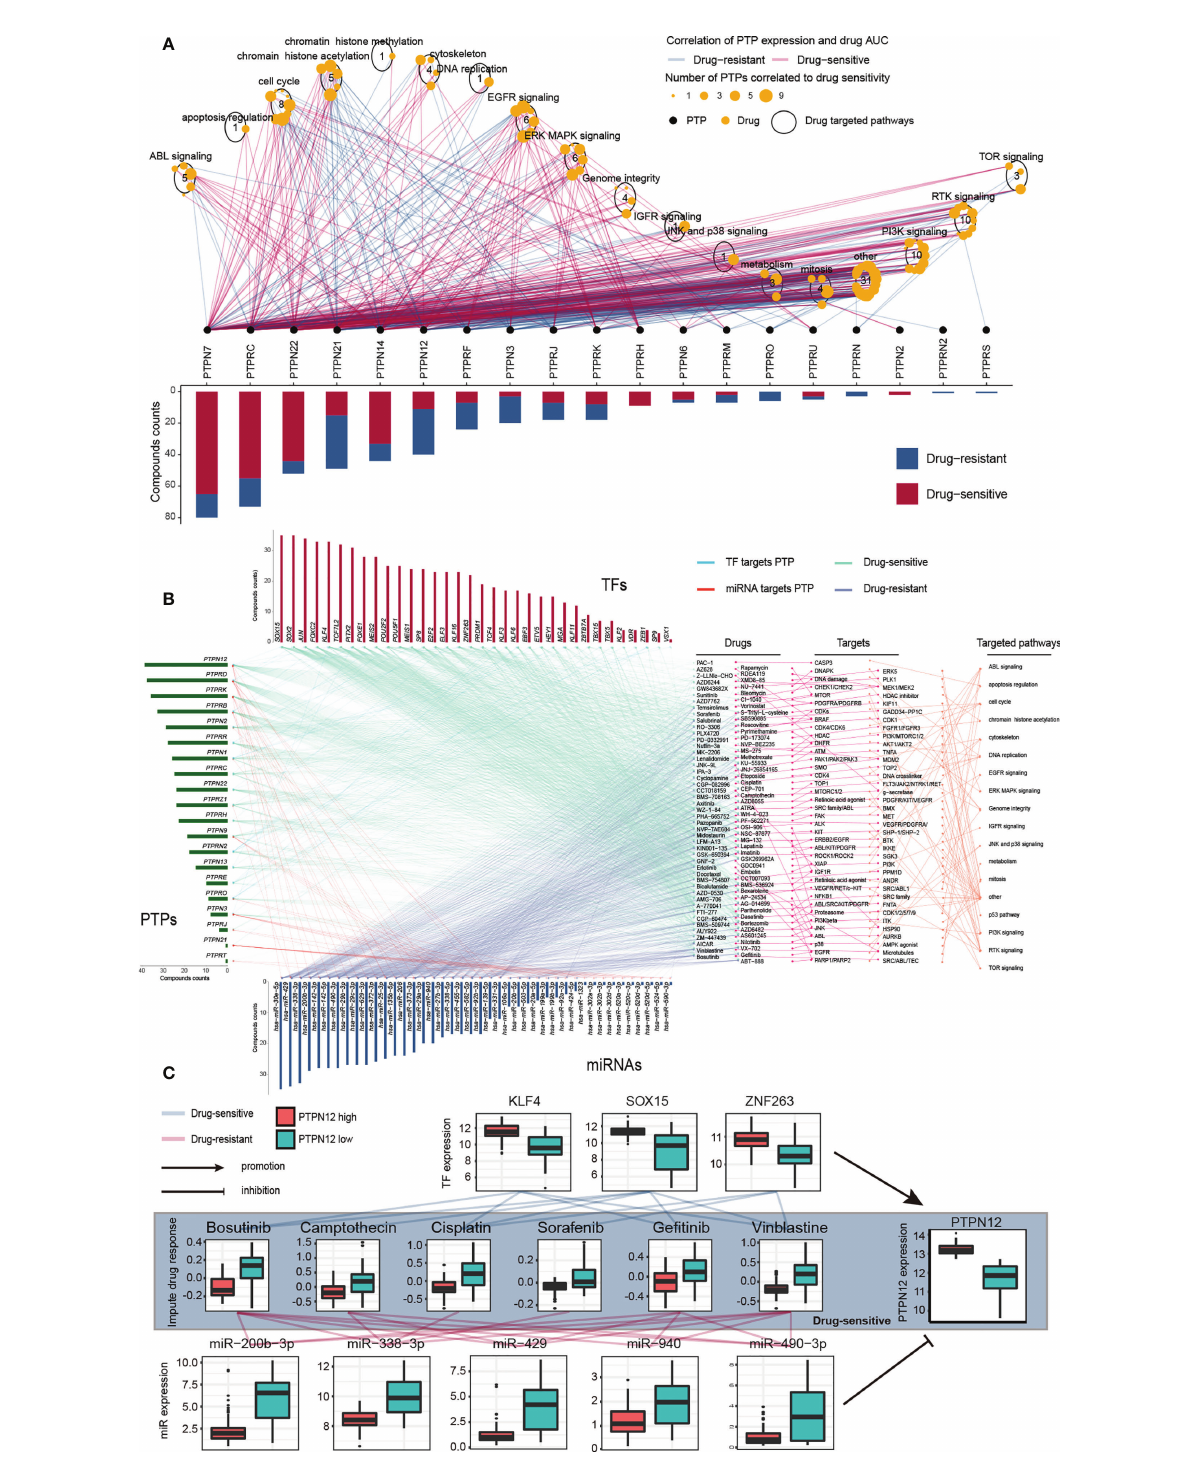
FIGURE 4 Signi fi cant correlation of classical PTPs to drug response in GDSC and imputed data from TCGA. (A) Spearman correlation between mRNA expression of classical PTPs and drug sensitivity across 1,074 cancer cell lines. (B) Sensitive interaction network of classical PTPs, PTP-targeted TFs, PTP-targeted miRNAs, and drug response in TGCT. (C) Representative drugs correlated to PTPN12 and corresponding TFs and miRNAs in